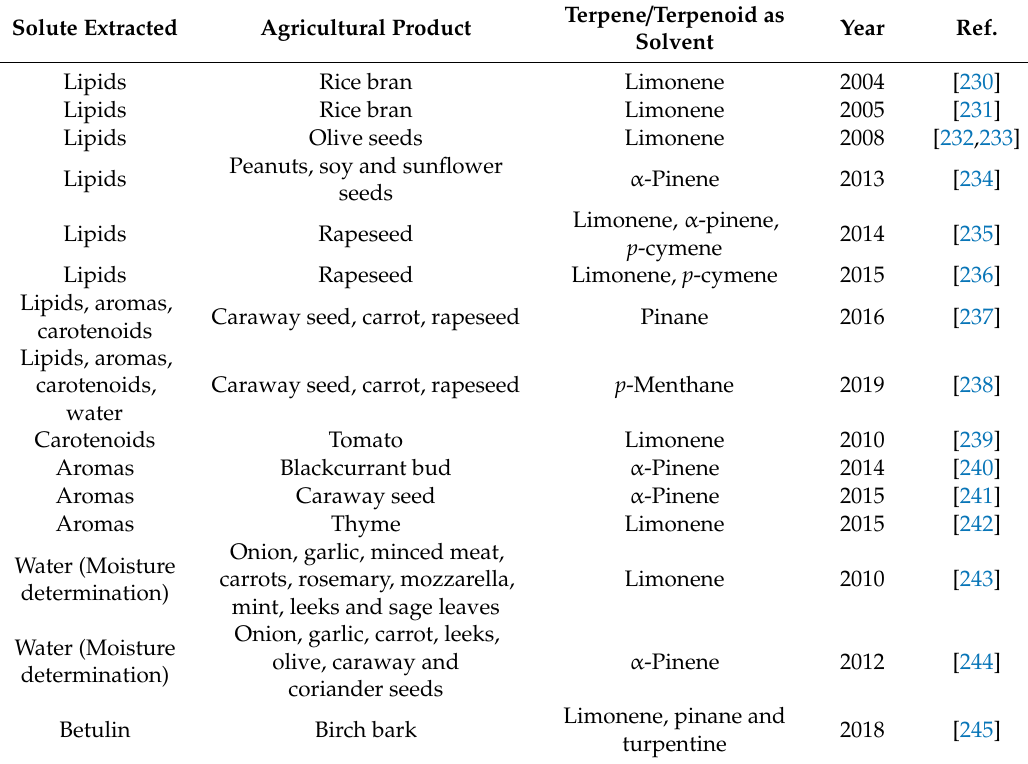
Table 10. Extraction Processes from Agricultural Products Using Terpenes and